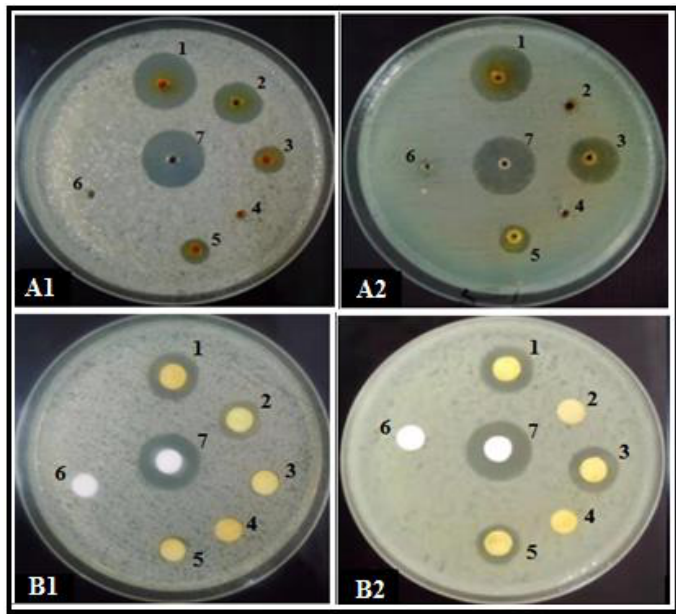
(Figure 1: A1,2). Similar results were seen when bioactivity was checked through the disc di ff usion method, where SMs of T. pseudoharzianum (T113) produced an inhibition zone of 20.0 and 20.4 mm against R. solanacearum and X. compestris through the disc di ff usion method (Figure 1: B1,2). The SMs of T. asperelloides (T136), T. pseudoharzianum (T129) and T. pseudoharzianum (T160) showed inhibition zones of 15.1, 14.2, 15.3 mm against R. solanacearum and 14.8, 15.2, 15.5 mm against X. compestris through